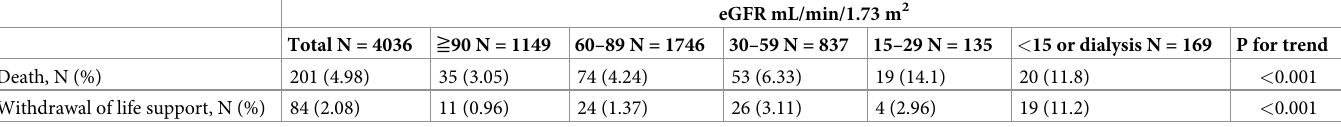
Table 4. In-hospital mortality rates for patients with intracerebral hemorrhage by eGFR levels on admission.